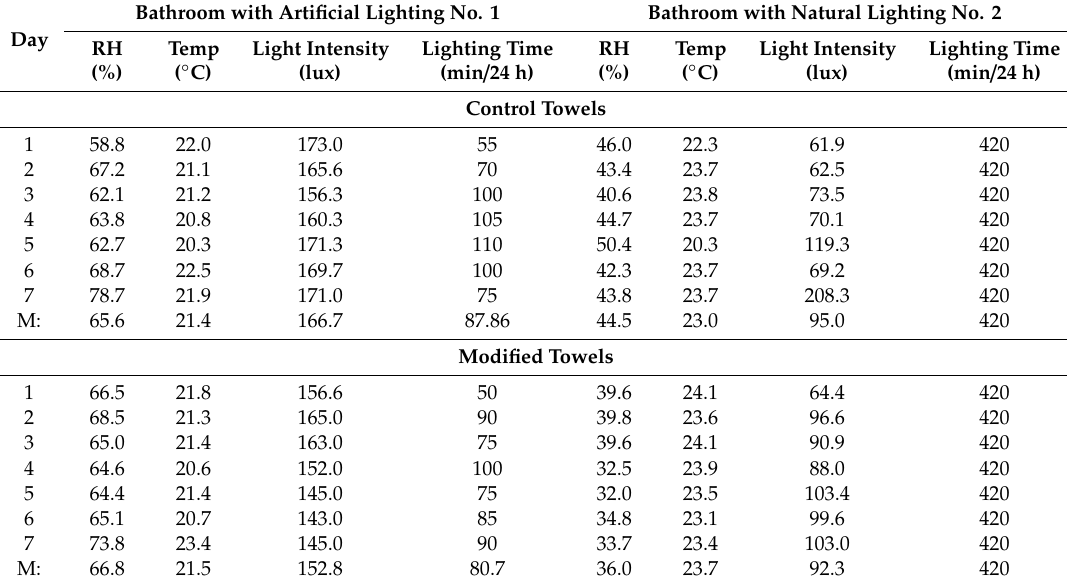
Table 4. Characteristics of microclimatic and lighting conditions in bathrooms during seven days of towel use—real